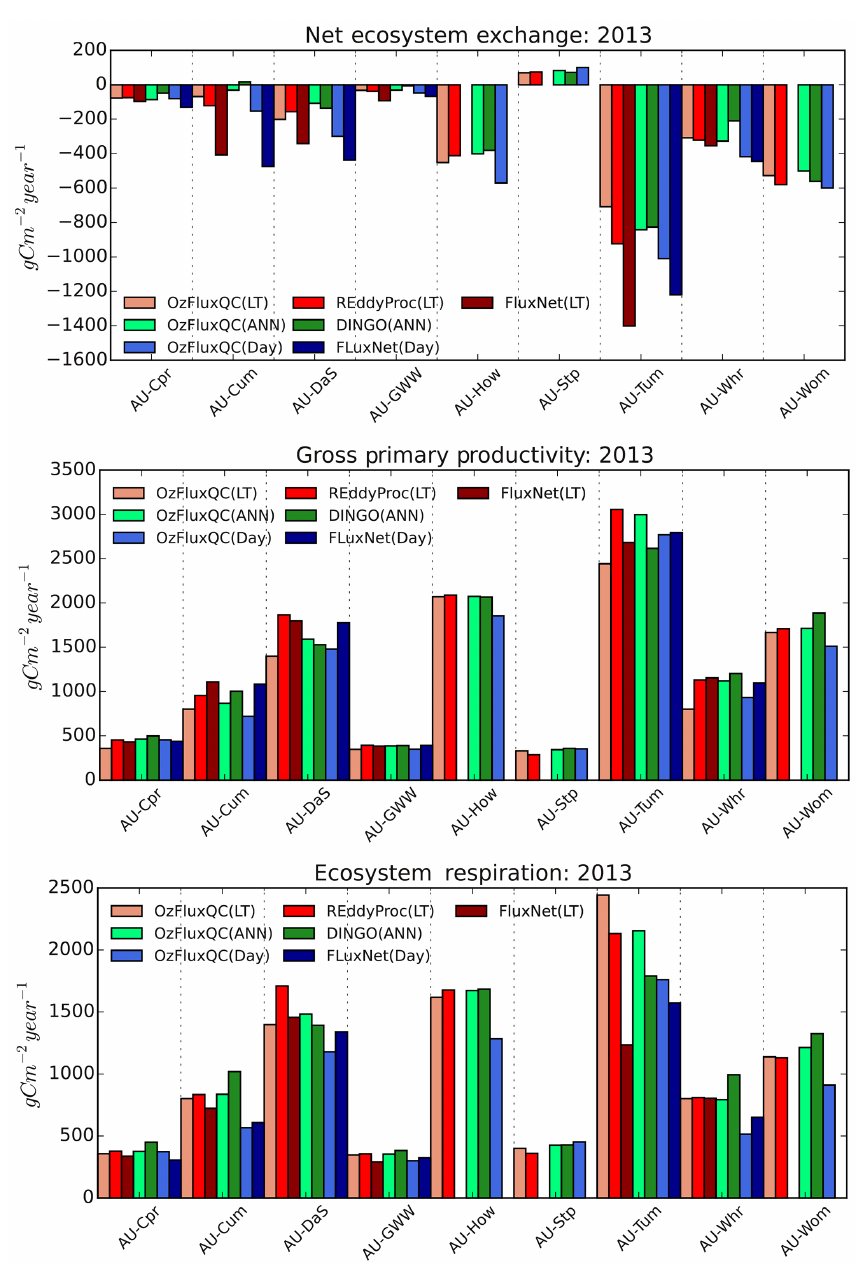
Figure 8. Bar chart of the annual sum of NEE, GPP and ER for nine OzFlux sites in 2013. The bars, from left to right for each site, give the results from the nocturnal method with the Lloyd–Taylor respiration model (OzFluxQC, light red; REddyProc, mid red; FLUXNET, dark red), the nocturnal method with an ANN respiration model (OzFluxQC, light green; DINGO, dark green) and the daytime method (OzFluxQC, light blue; FLUXNET, dark